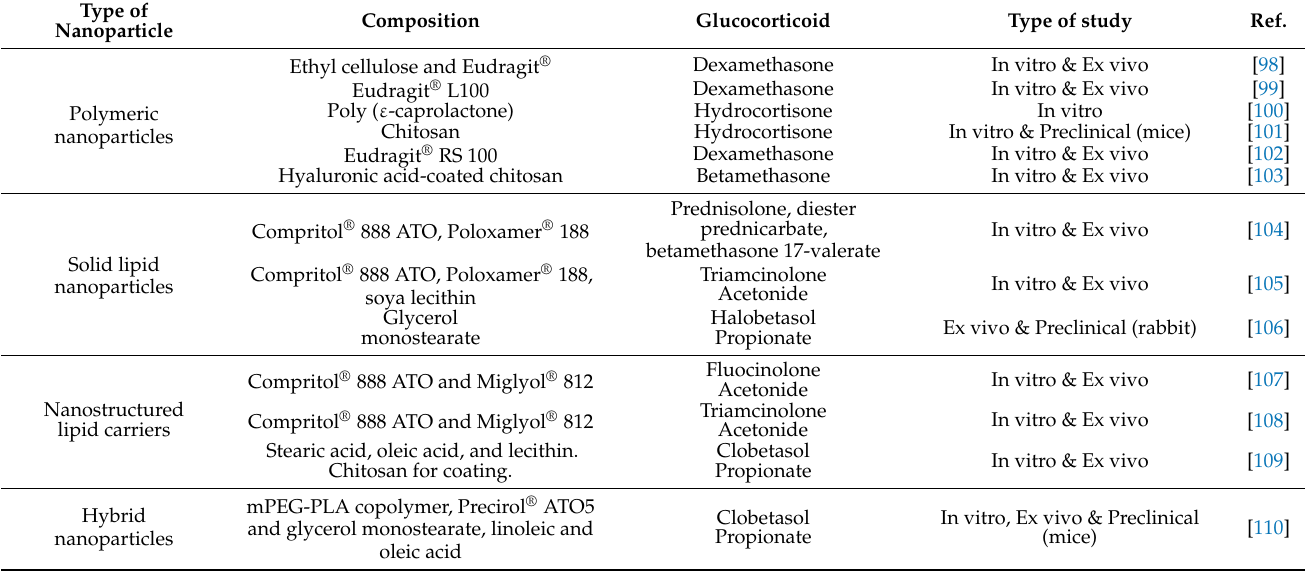
Table 2. Summary of glucocorticoid-loaded nanodelivery systems designed for topical